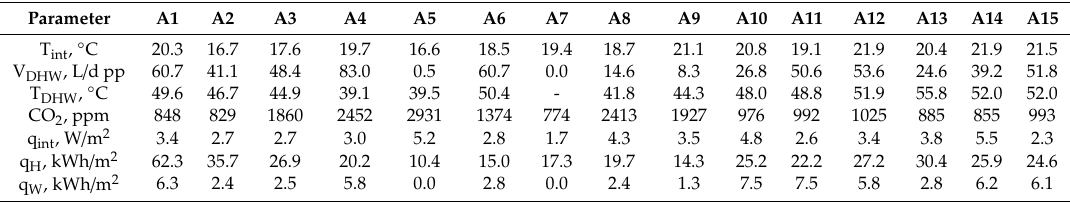
Table 3. Results of the measurements: conditions during measurements and standard of use of apartments.